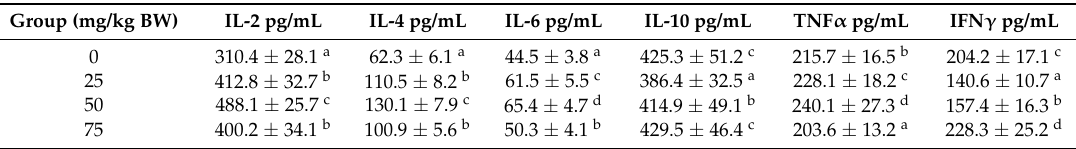
Table 4. Effect of oral administration with the SCP on CD3/CD28-induced cytokines production by lymphocyte of C57BL/6 mice.